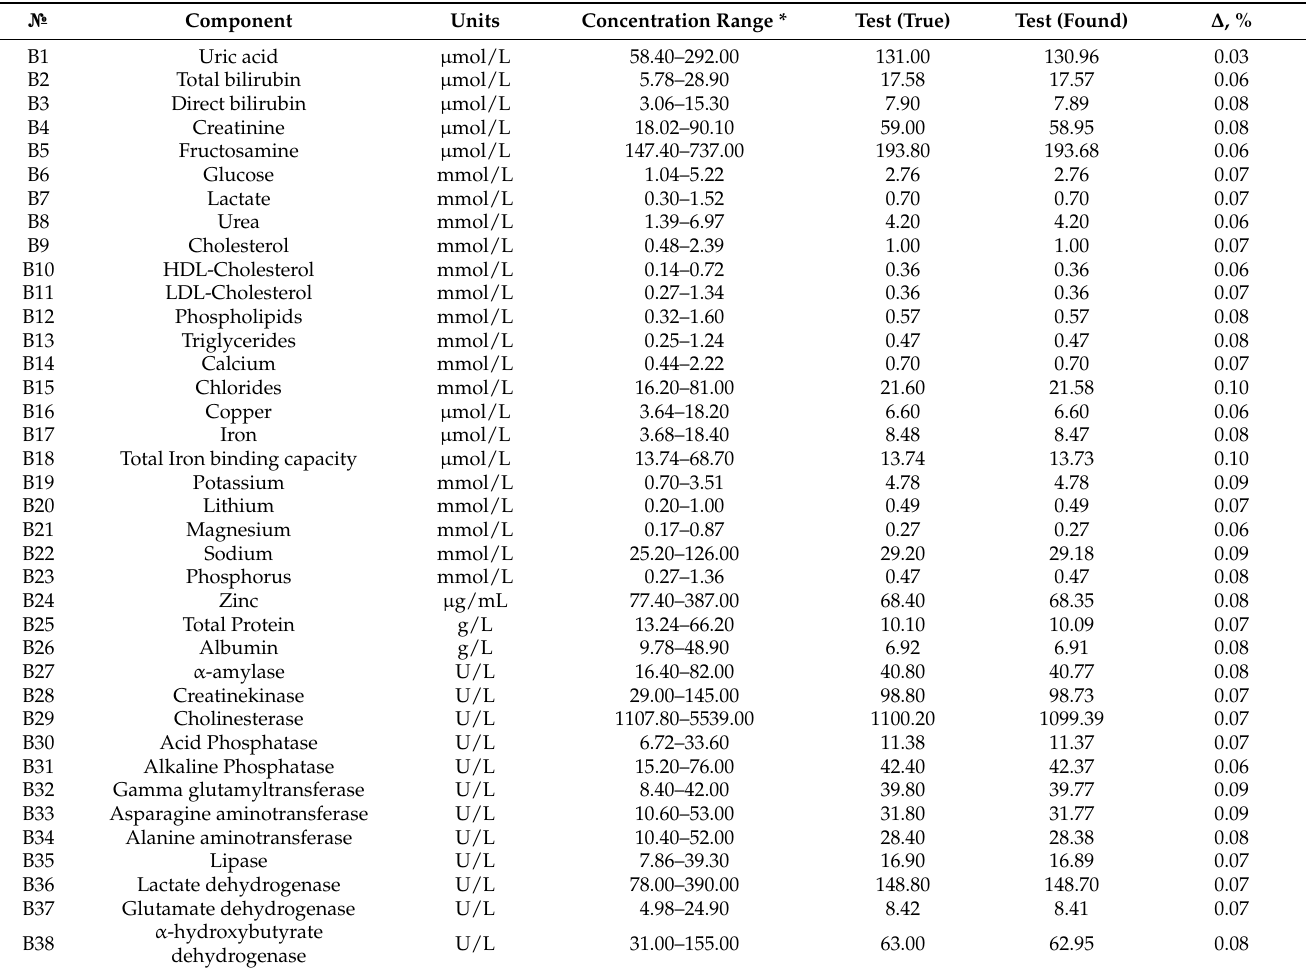
Table 2. List of components and concentration range of model